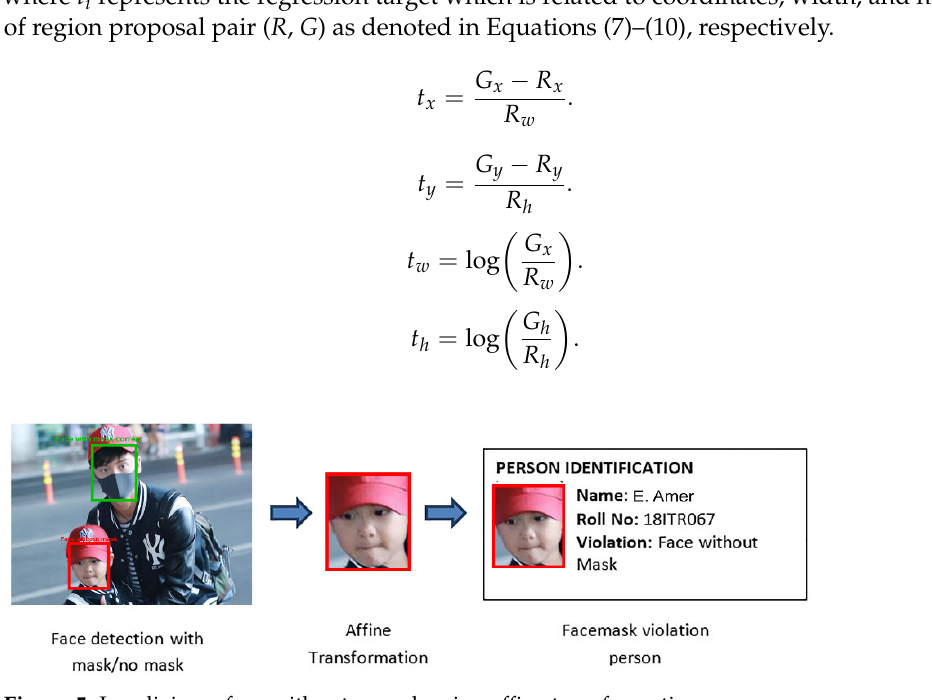
Figure 5. Localizing a face without a mask using affine